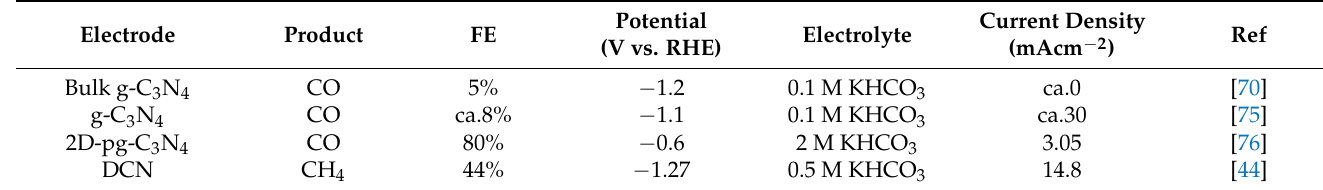
Table 3. Electrocatalytic parameters of the pristine g-C 3 N 4 catalysts in eCO 2